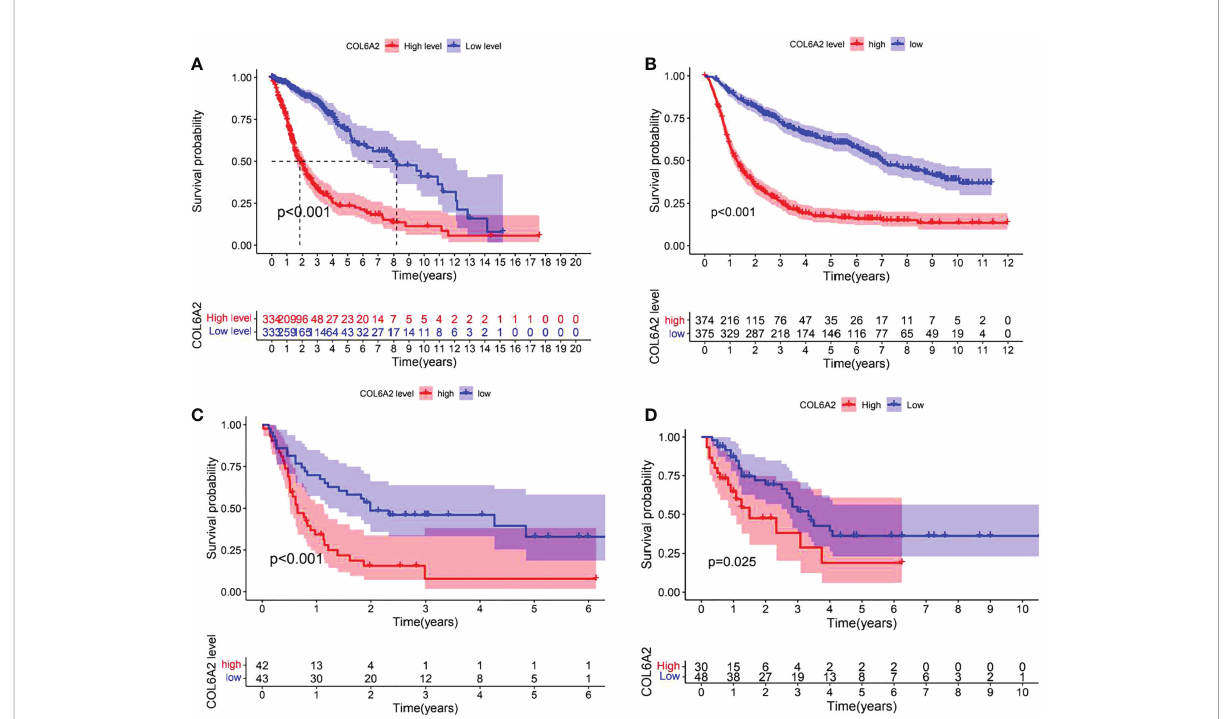
FIGURE 3 Effect of COL6A2 expression on prognosis of glioma. (A) Data indicate that the expression levels of COL6A2 are associated with poor prognostic survival in glioma patients in the TCGA cohort. (B) In CGGA database, high expression of COL6A2 is a poor prognostic factor for glioma